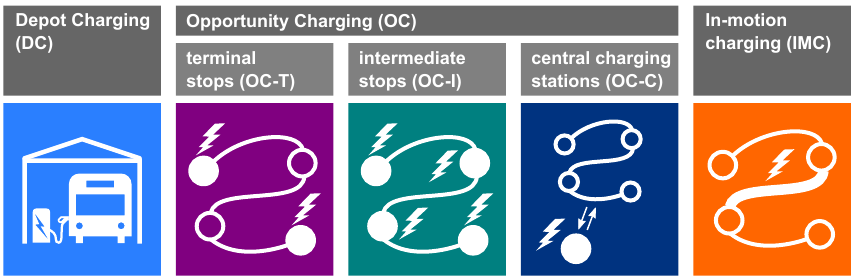
Figure 1. Electric bus charging